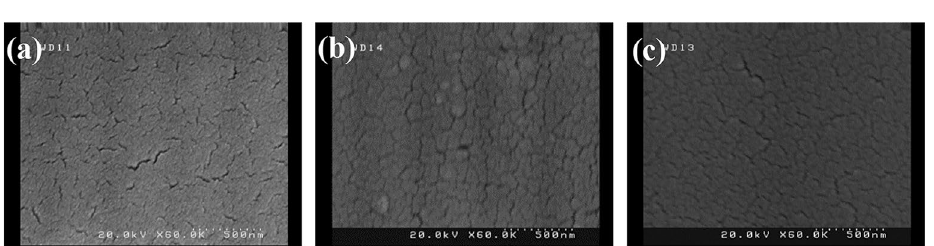
Figure 5. SEM images of TON-Van-Gel C7 soaked in PBS and freeze dried (a) before drug release (b) after 10 days, and (c) after 17